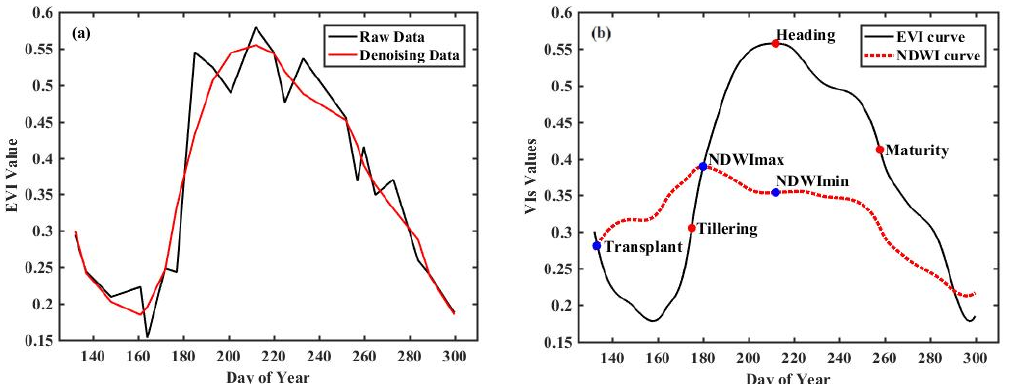
Figure 3. ( a ) The raw EVI data and the reconstructed EVI time-series curve fitted by WS. ( b ) The key phenology-based dates extracted from temporal profiles of EVI and NDWI(1).